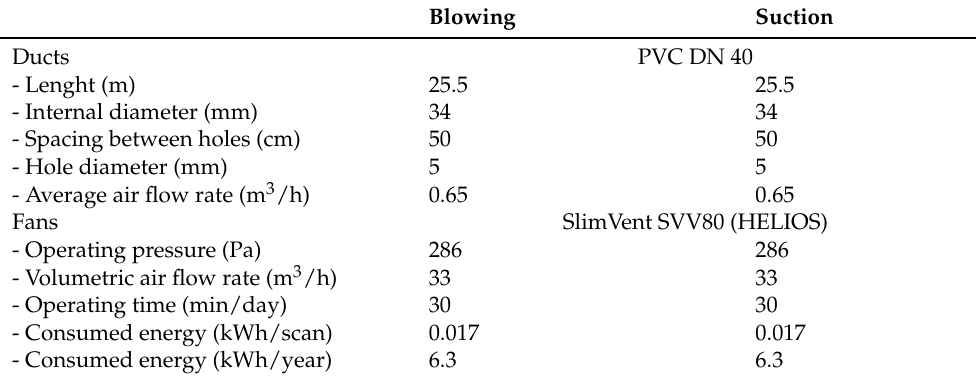
Table 1. Specifications of the aeraulic